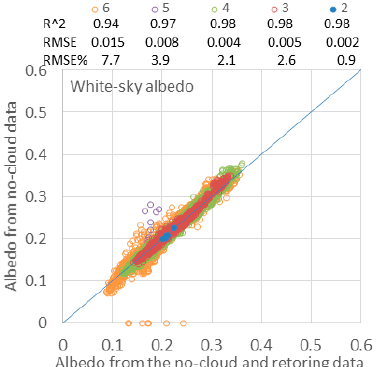
Figure 12. A 2D scattering plot of the land surface albedo (white-sky albedo) retrieved from no-cloud data and mixed data including no-cloud and restored cloudy pixels according to different cloudy pixel numbers (2, 3, 4, 5, and 6).